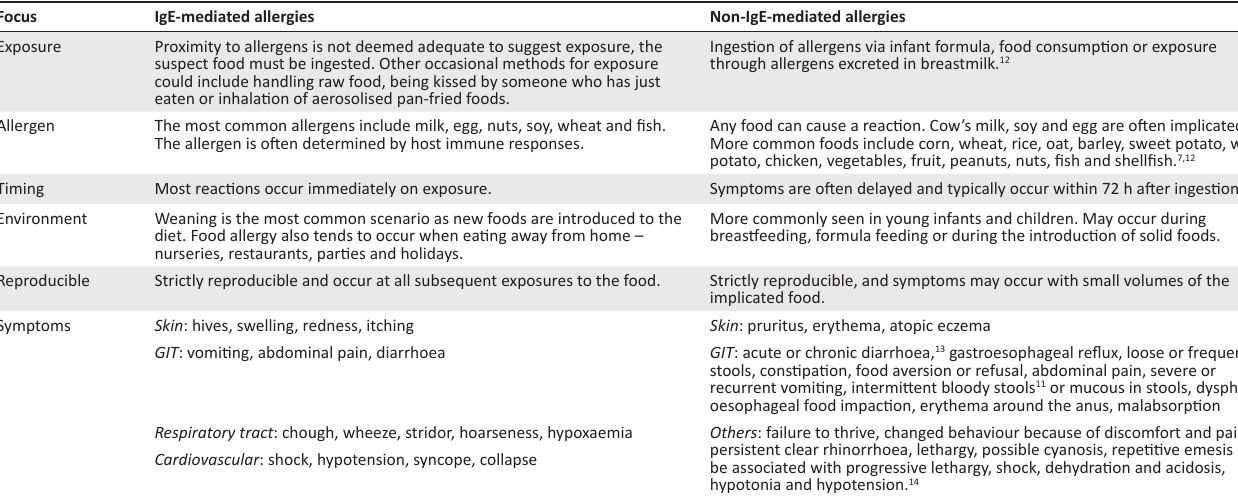
FIGURE 1: Classification of adverse food TABLE 1: EATERS mnemonic.